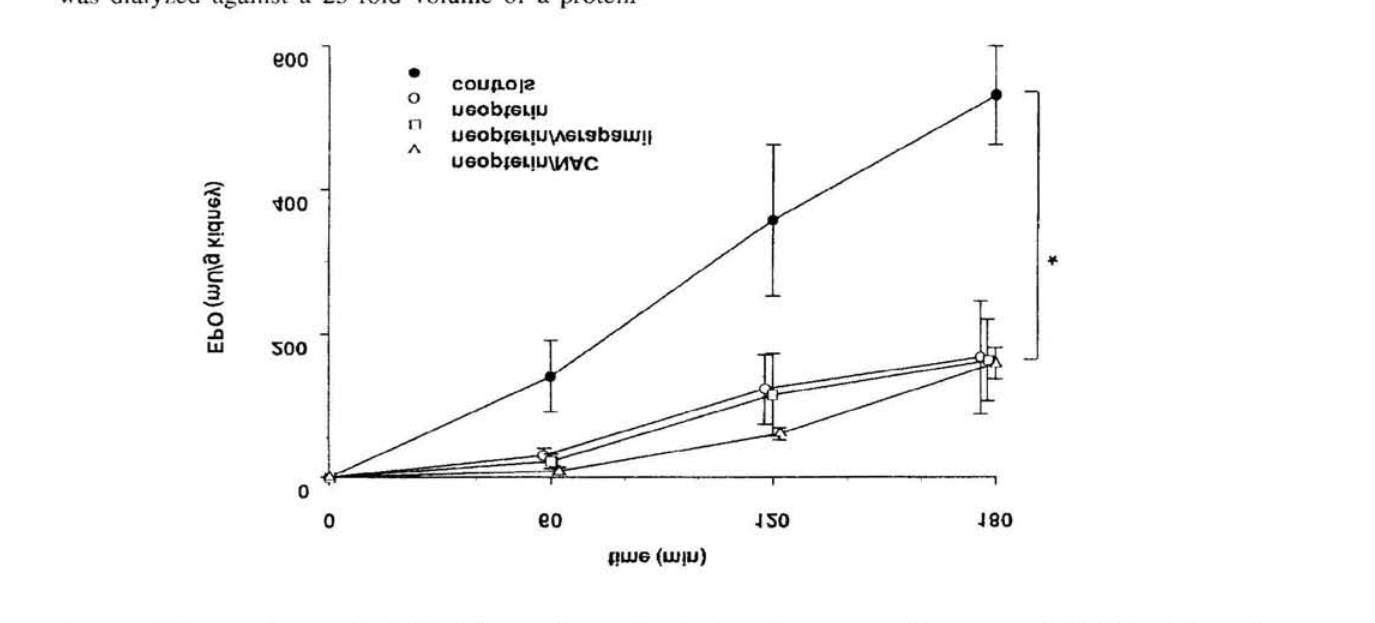
Figure 1. Effects of neopterin (200 | j M ) as well as co-incubation of neopterin with Verapamil (5 | j M ) or N -acetyl- cysteine (NAC, 200 pM) on hypoxia-induced erythropoietin (EPO) production in the isolated perfused rat kid- ney. Data are given as mean ± SEM of 4 (controls) or 3 (treatment groups) different experiments. *p <0.05 as compared to the 180 min control